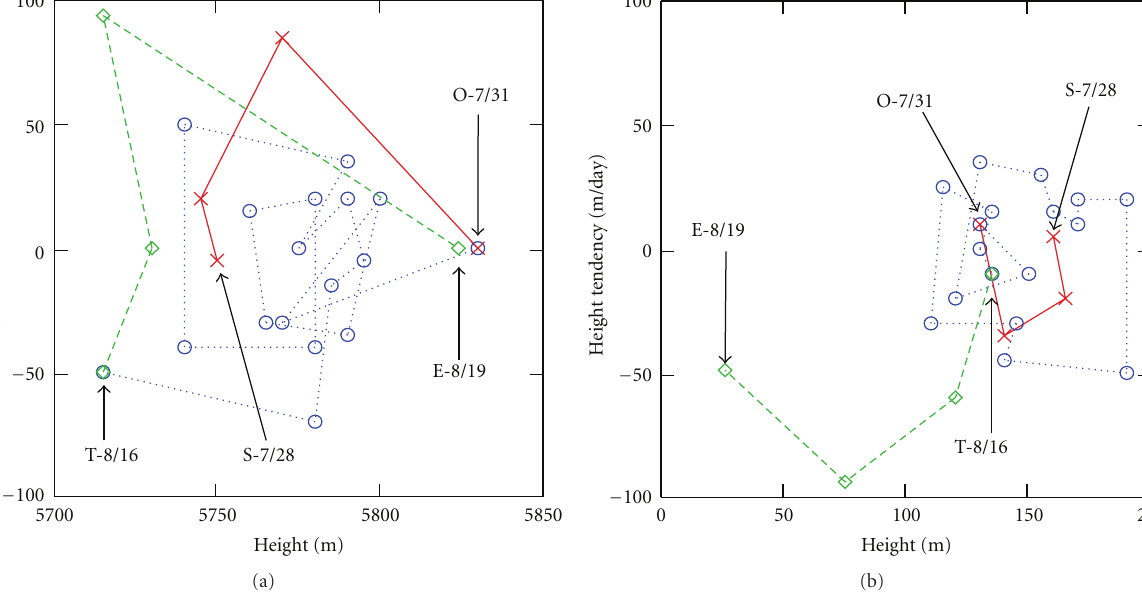
Figure 5: As in Figure 4, except for the August 2010 blocking